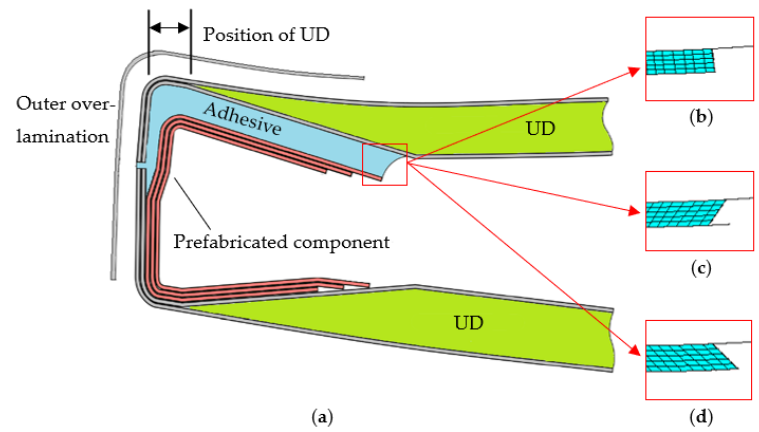
Figure 5. Modeling strategies in the calculation: ( a ) Summary of four structural configurations; ( b ) Chamfer was set perpendicular to the bonding surface in the benchmark model; ( c ) The angle between the chamfer surface and the bonding surface of PS was obtuse; ( d ) The angle between the chamfer surface and the bonding surface of PS was acute.